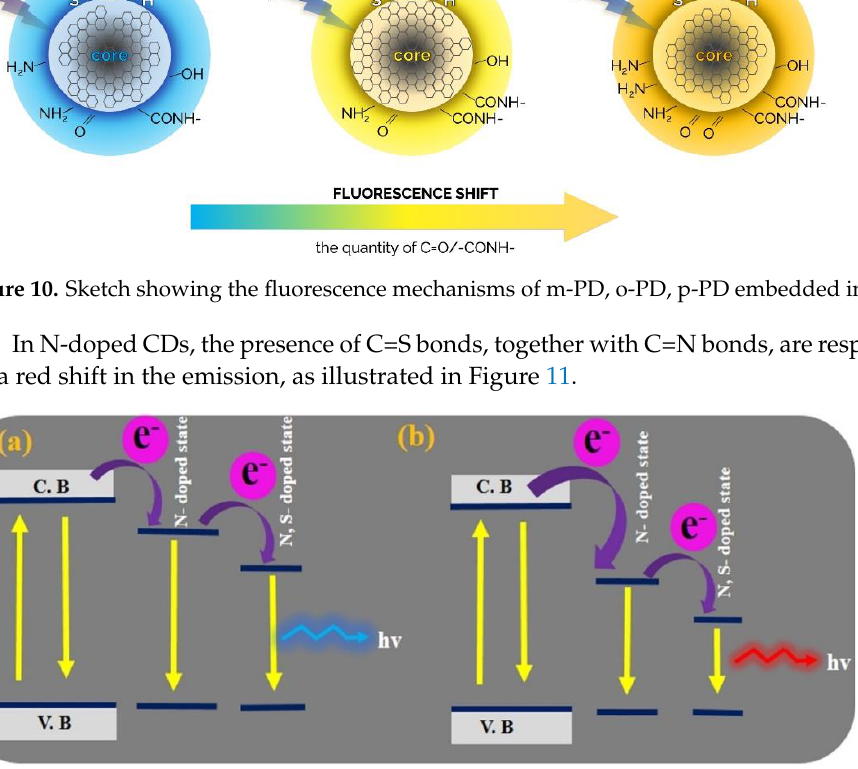
Figure 11. Illustration showing the energy states with different color emission by ( a ) m – CDs and ( b ) o-CDs. (Reprinted from [116]; with the permission of John Wiley and Sons).